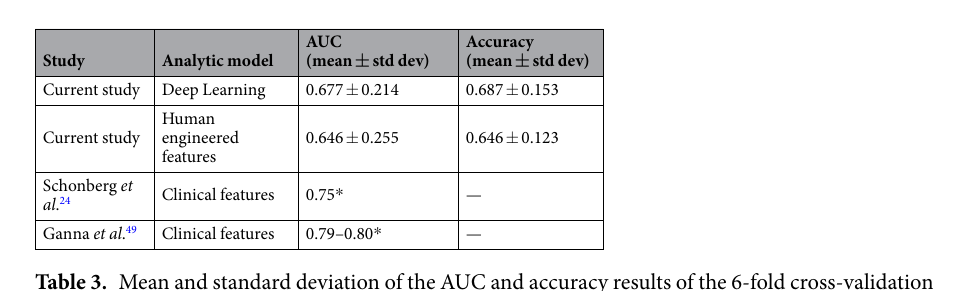
Figure 3. Pooled ROC curves of the 6-fold cross validation experiment to predict 5 year mortality and survival outcomes from CT chest imaging, comparing the deep learning model and the human feature engineering/ random forest model.